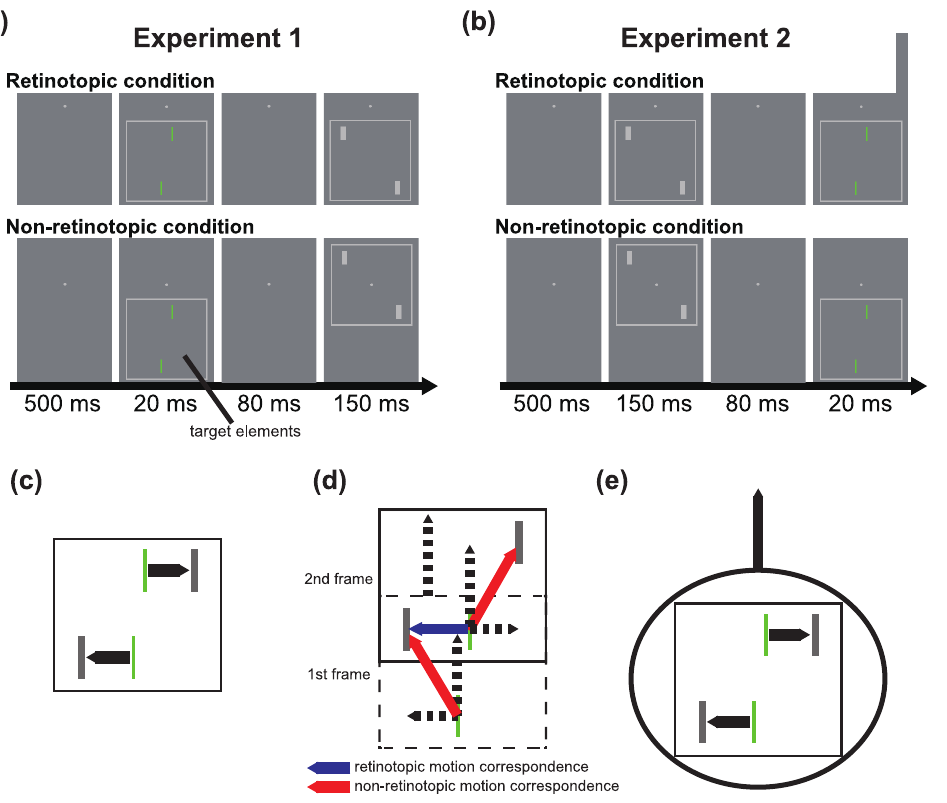
Figure 2. Stimuli. (a, b) Schematic representations of the time course of the stimuli used in (a) Experiment 1 and (b) Experiment 2. In the non- retinotopic condition, the visual target elements moved synchronously with the frame stimulus. (c) Motion vectors in the retinotopic condition. In this situation, there is no common component in decomposed motion vectors between bars and thus perceived motion direction is defined by retinotopic motion correspondence (the solid vectors) that is dependent on spatiotemporal proximity between the bars. (d) Decomposed motion vectors (the dashed vectors) in the non-retinotopic condition in Experiment 1. The blue solid vector represents retinotopic motion correspondence between the frames that is dependent on spatiotemporal proximity between the bars. The red solid vectors represent non-retinotopic motion correspondence between the frames. In this situation, the common (vertical) component served as a reference frame and the residual (horizontal) vectors define the perceived direction of non-retinotopic motion. (e) The resultant perceived motion direction in the non-retinotopic condition. Horizontal non-retinotopic motion (represented by the horizontal solid vectors) occurs with vertical group motion of the elements and the frame stimulus (represented by the vertical solid vector and the circle). The length of the horizontal motion vectors in motion correspondence in the retinotopic condition (shown in c) is equal to the horizontal components in motion correspondence in the non-retinotopic condition (shown in d). That is, the intensity of horizontal non-retinotopic motion is equal to horizontal retinotopic motion.